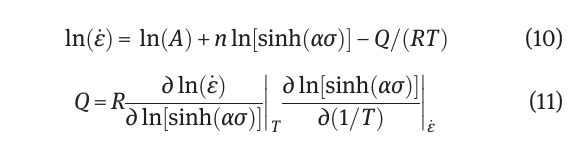
Figure 6: Relationships between (a) ln ð ε . Þ − ln ð σ Þ ; (b) ln ð ε . Þ − σ ; (c) ln ð ε Þ